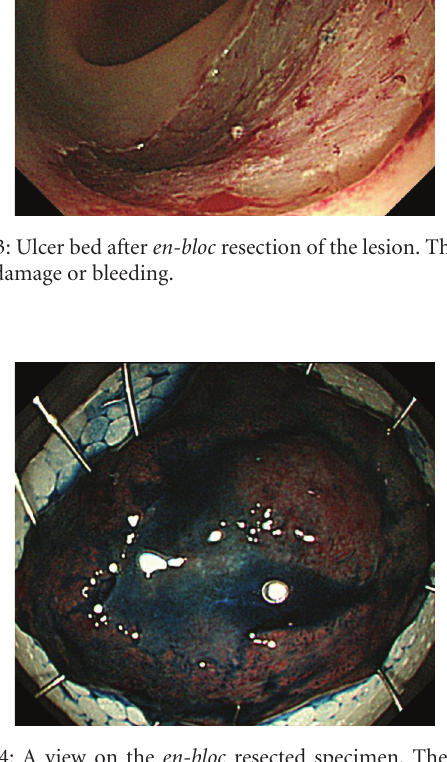
Figure 2: Direct observation of the submucosal and muscle layers is possible due to the utility of distal attachment.